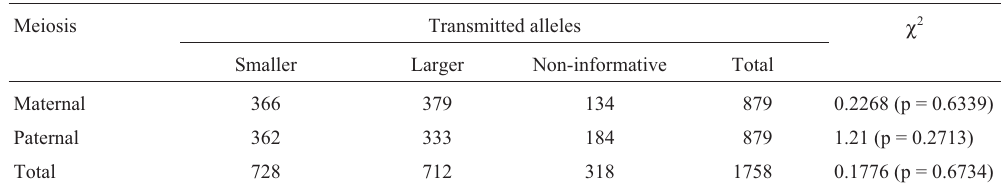
Table 2 - Transmission of larger and smaller MJD alleles by normal